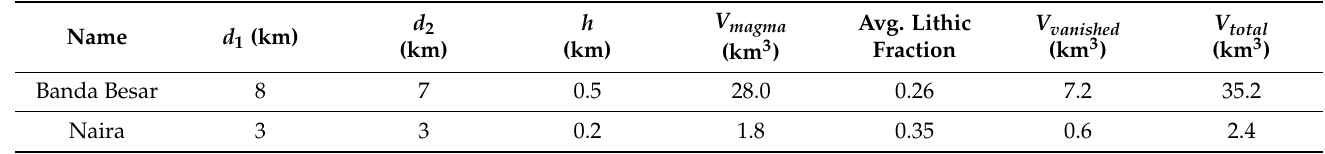
Table 2. Volume estimation of Banda Besar and Naira pumice